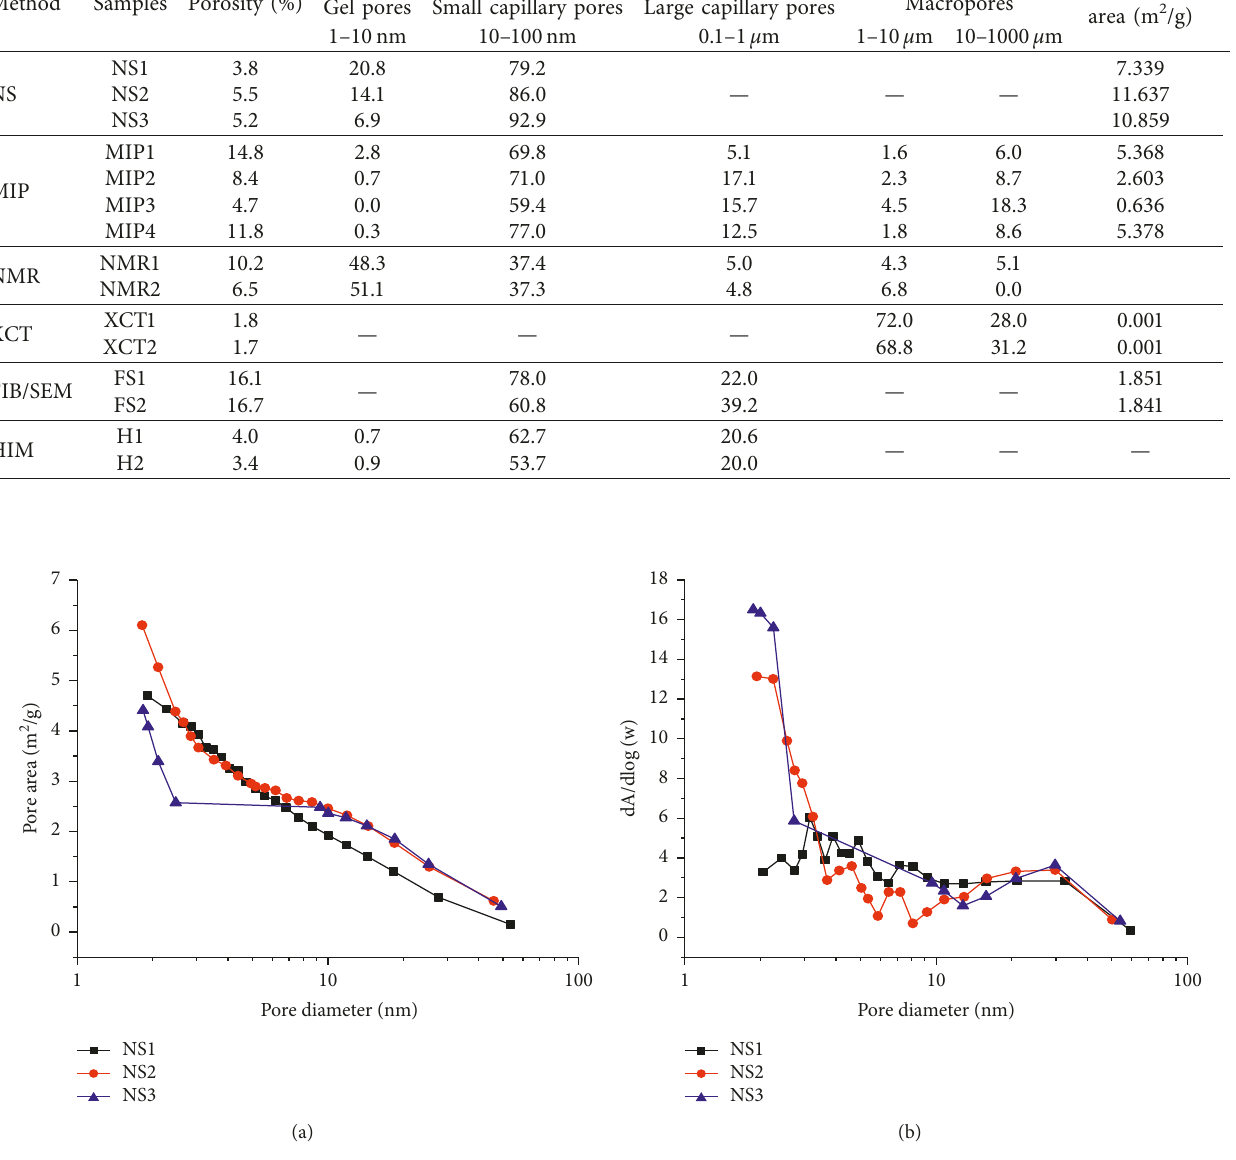
Figure 5: Pore surface area distribution of hardened cement paste by NS: (a) cumulative curve; (b) relative